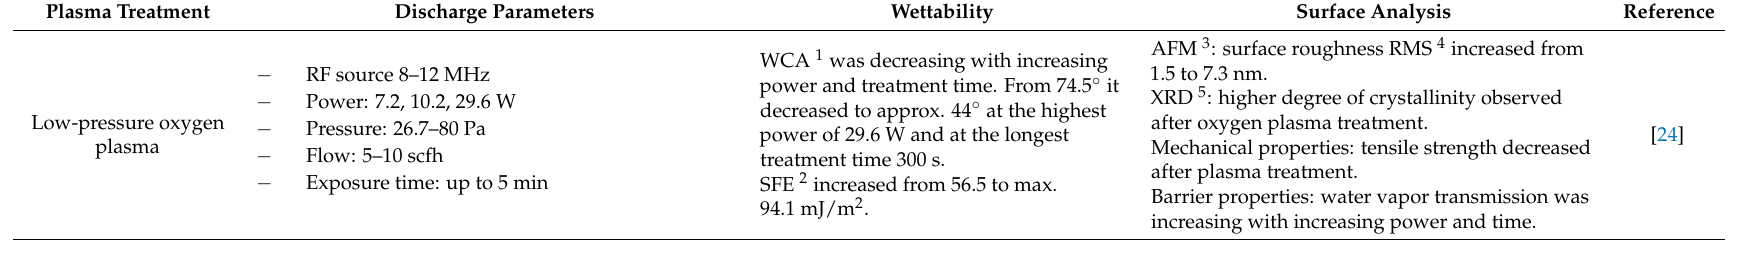
Table 1. Treatment conditions and results obtained by other